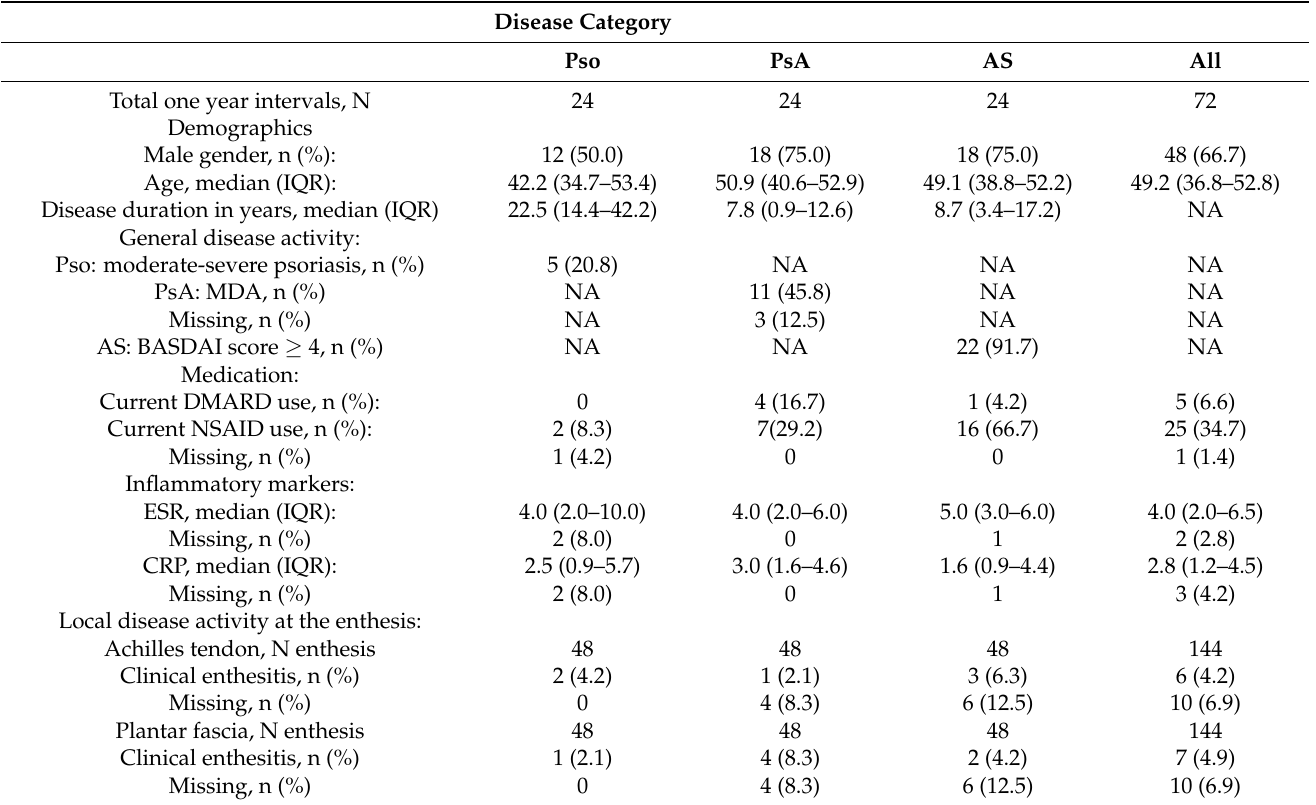
Table Legend. Abbreviations: AS = ankylosing spondylitis, BASDAI = Bath Ankylosing Spondylitis Disease Activity Index, CRP = C-reactive protein, DMARD = disease-modifying anti-rheumatic drugs, ESR =